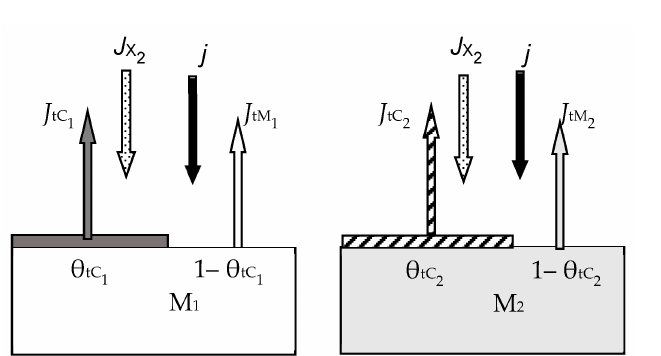
Figure 8. The fl uxes on the surface of the targets. Figure 8. The fluxes on the surface of the